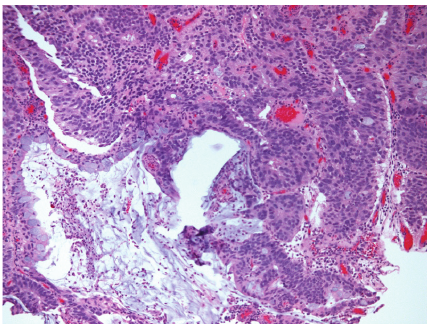
Figure 3: Medium-power photomicrograph of tumour showing abundant acid mucin (amorphous pale blue material within glands and extravasated from large gland at bottom left): confluent glands define a Gleason 4 pattern.